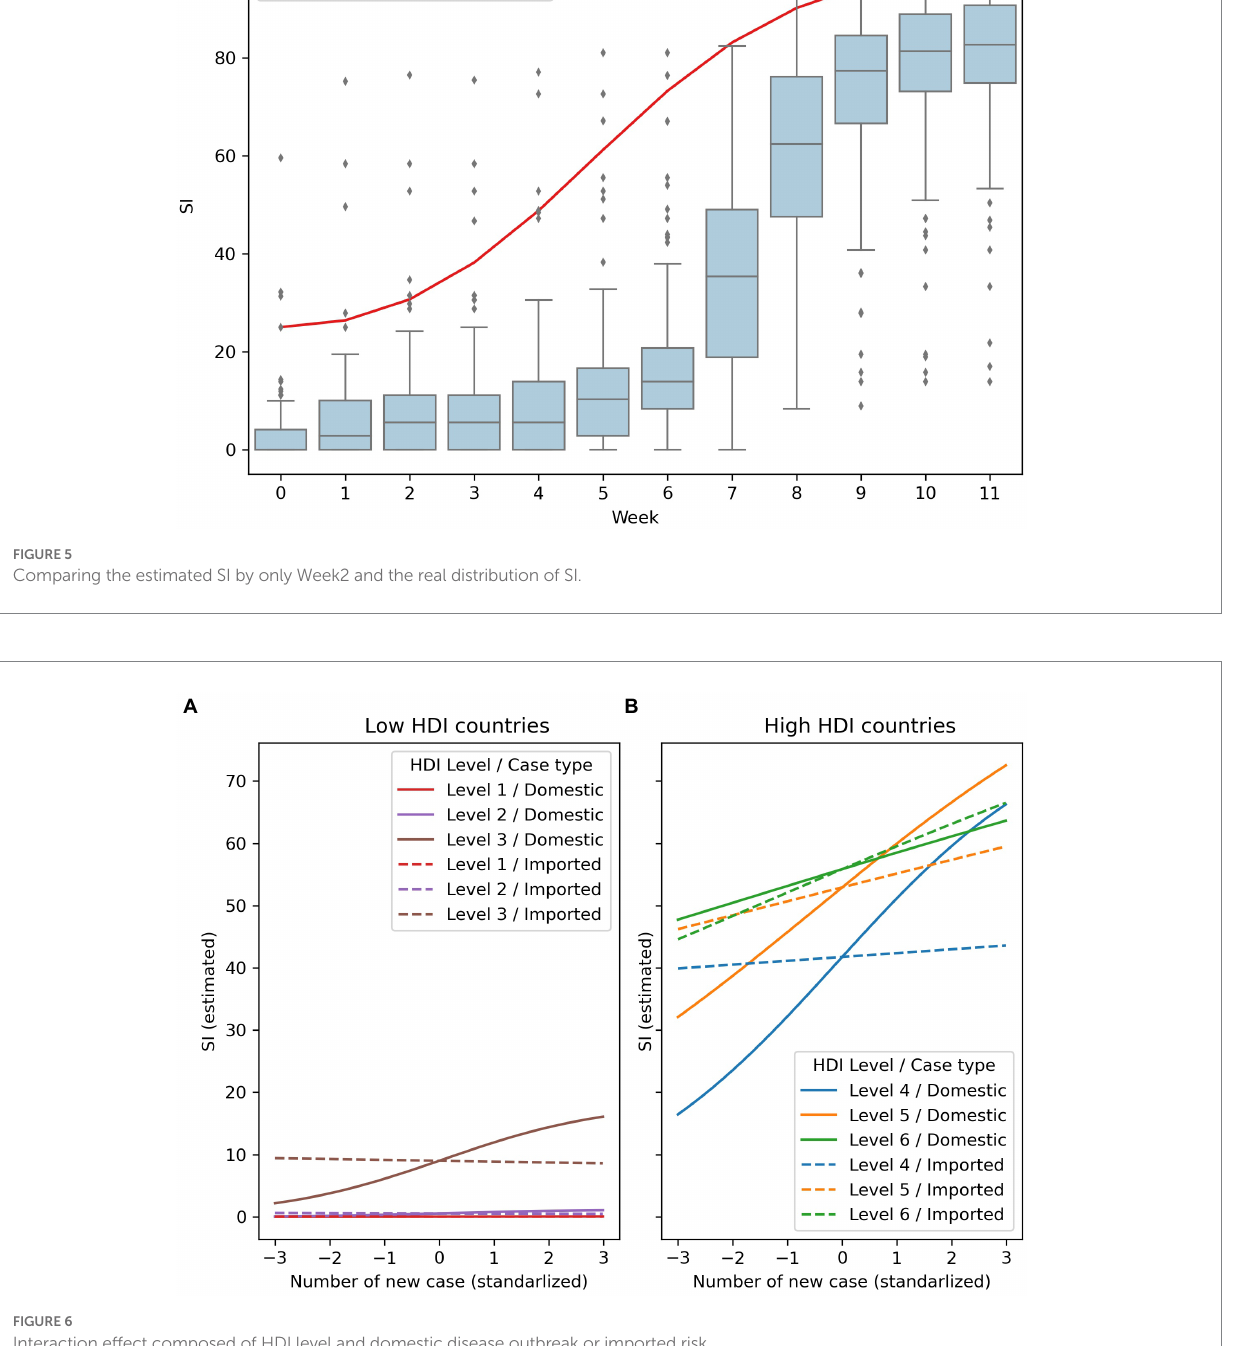
FIGURE 6 Interaction effect composed of HDI level and domestic disease outbreak or imported